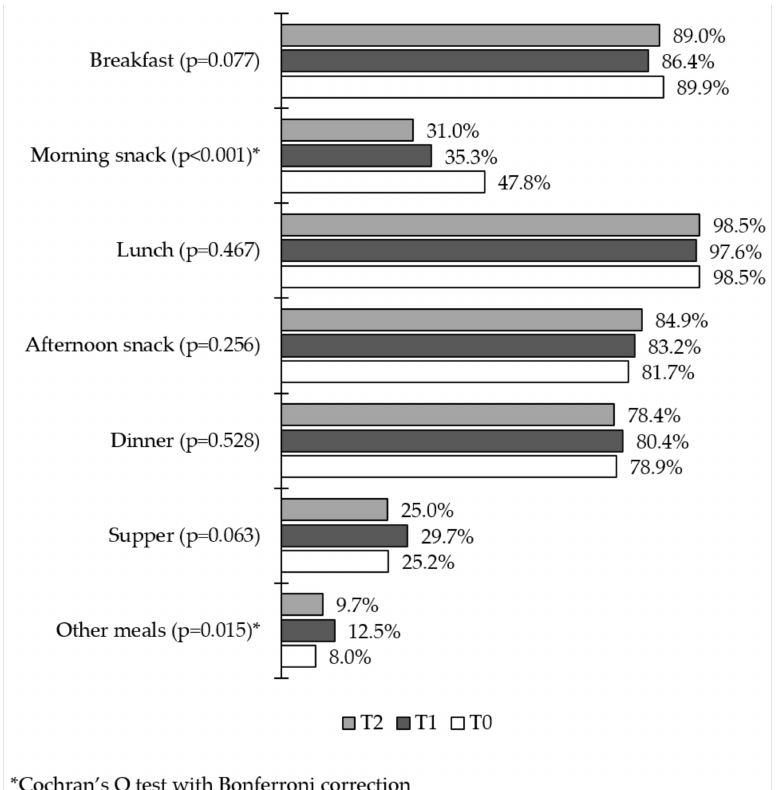
Figure 5. Daily meals in the first and second phases of the